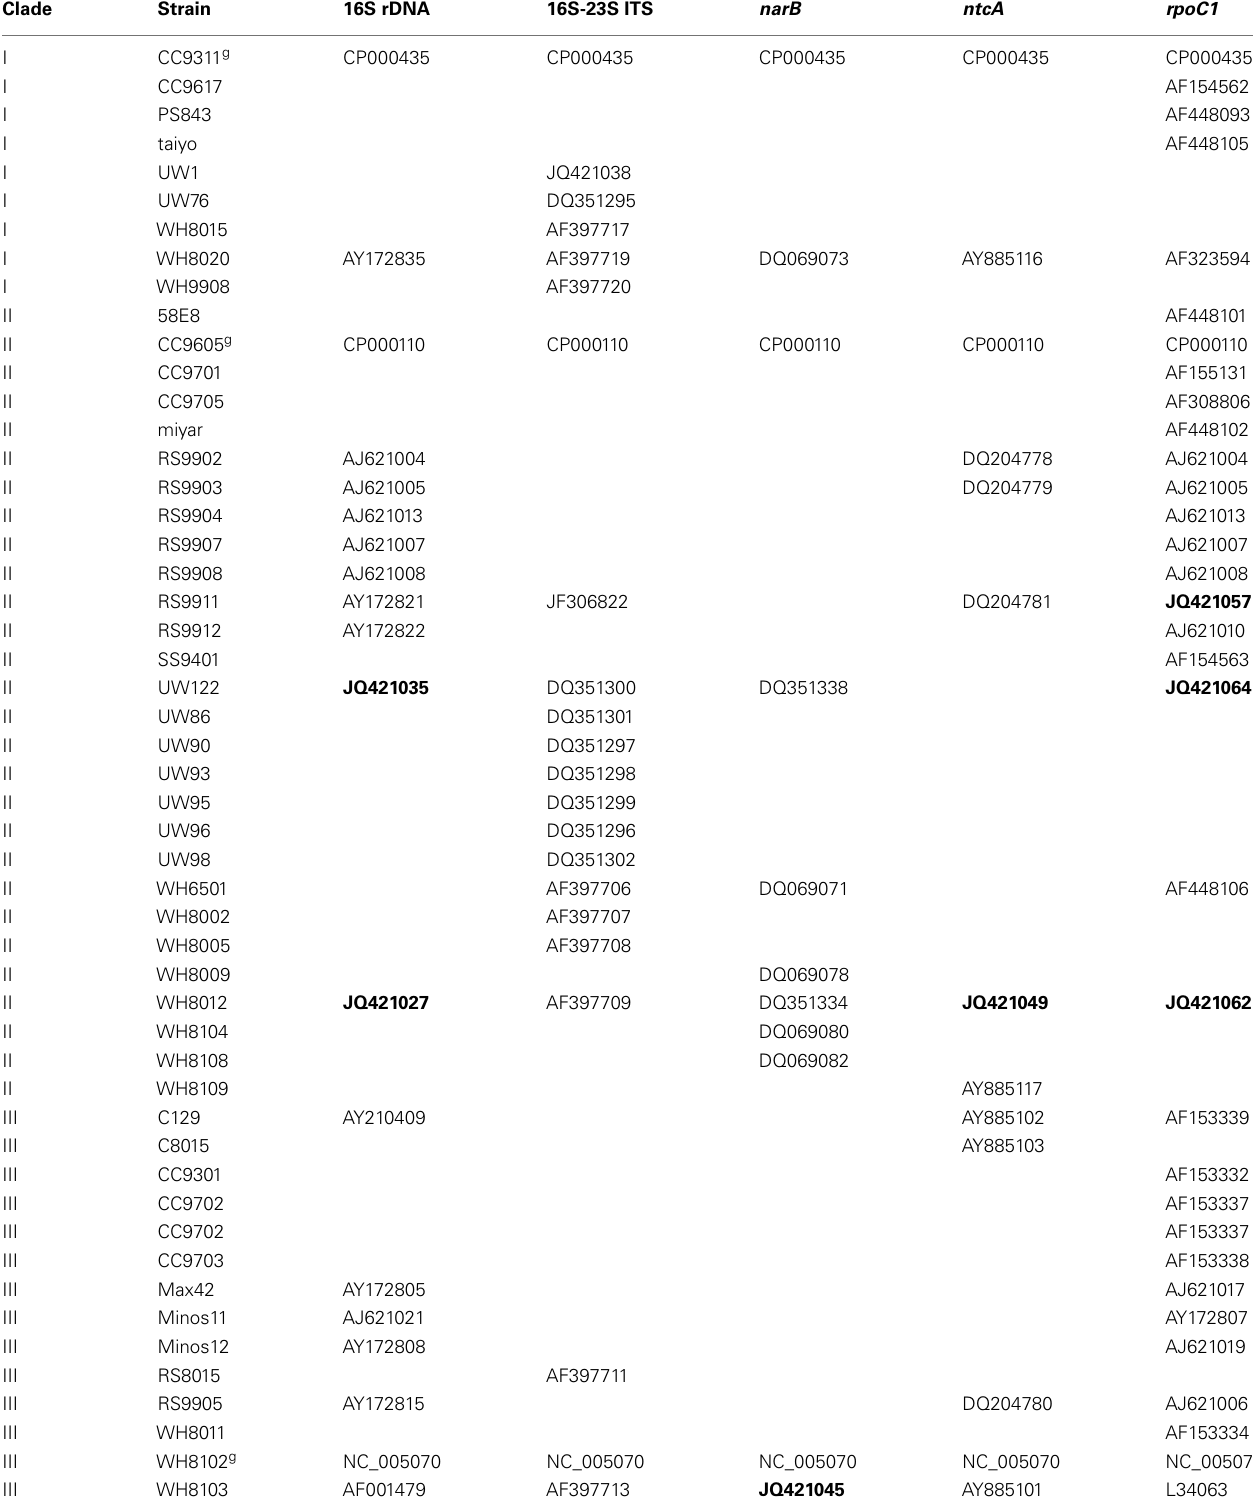
TableA2 | Classification of cultured strains and GenBank accession numbers of sequences used for multiple gene phylogenies.